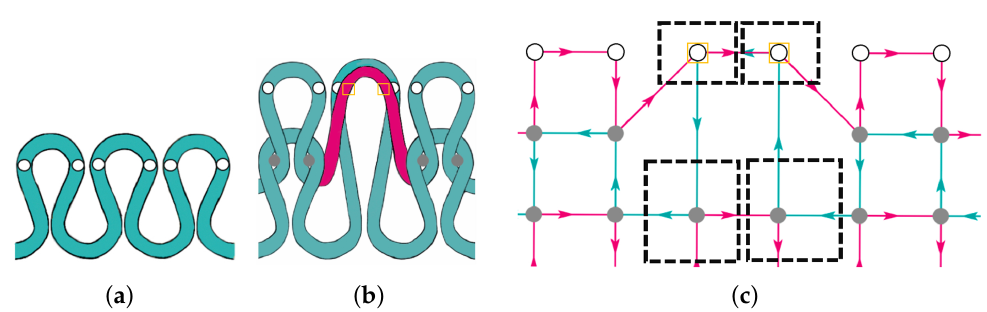
Figure 7. A Back Tuck stitch is created by tucking a yarn onto a loop held by a needle on the back bed from the previous row, instead of creating a new stitch. ( a ) Row of loops. ( b ) Two Knit stitches and a Back Tuck stitch produced from another row of stitches. ( c ) Topological representation.